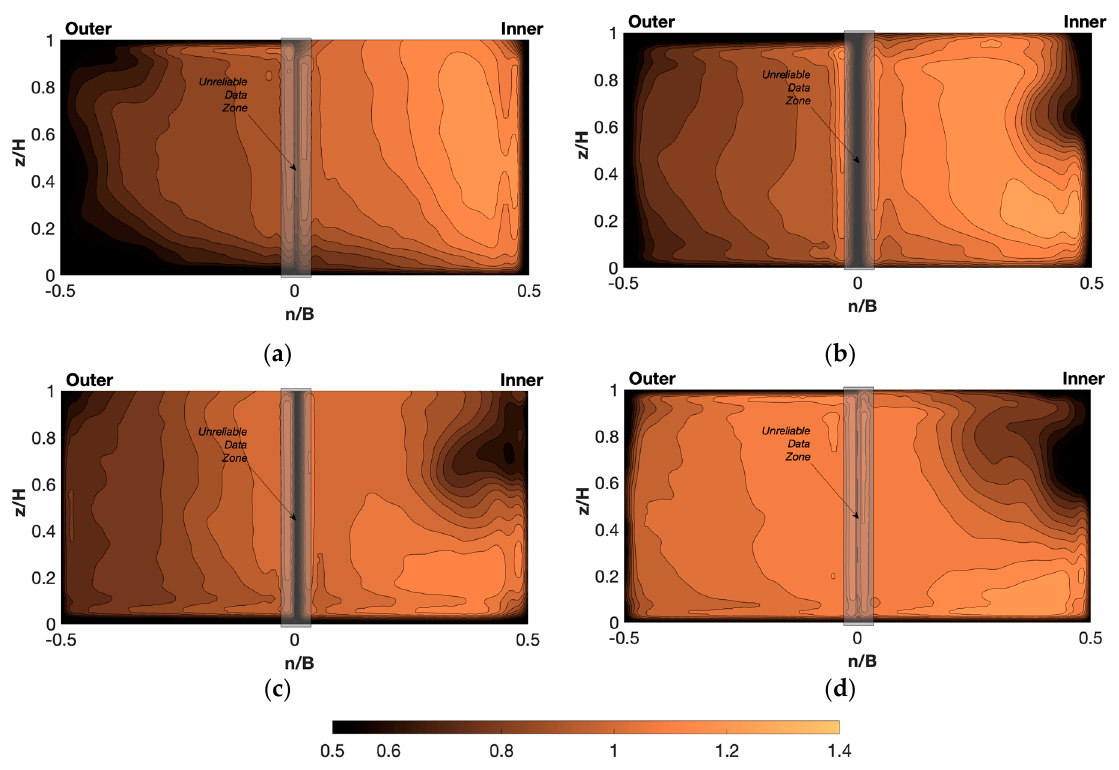
Figure 3. Streamwise velocity of the measured cross-sections without the jets: ( a ) 37 degrees, ( b ) 90 degrees; ( c ) 105 degrees; ( d ) 125 degrees. ( b ) 90 degrees; ( c ) 105 degrees; ( d ) 125